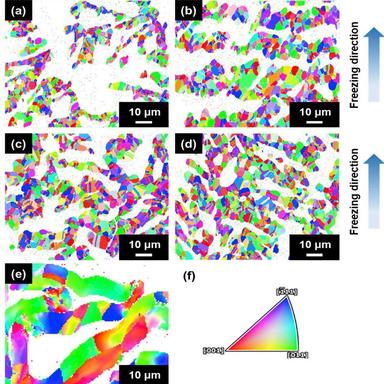
Orientation imaging microscopy (OIM) maps of (a, c) perpendicular and (b, d) parallel to freezing direction of Ni foam with varying NiO slurry fraction: (a, b) 5 vol% and (c, d) 7 vol%, and (e) commercially available Ni foam. The orientation color of each grain is based on the inverse pole figure (IPF) legend (f). (For interpretation of the references to color in this figure legend, the reader is referred to the Web version of this article.)